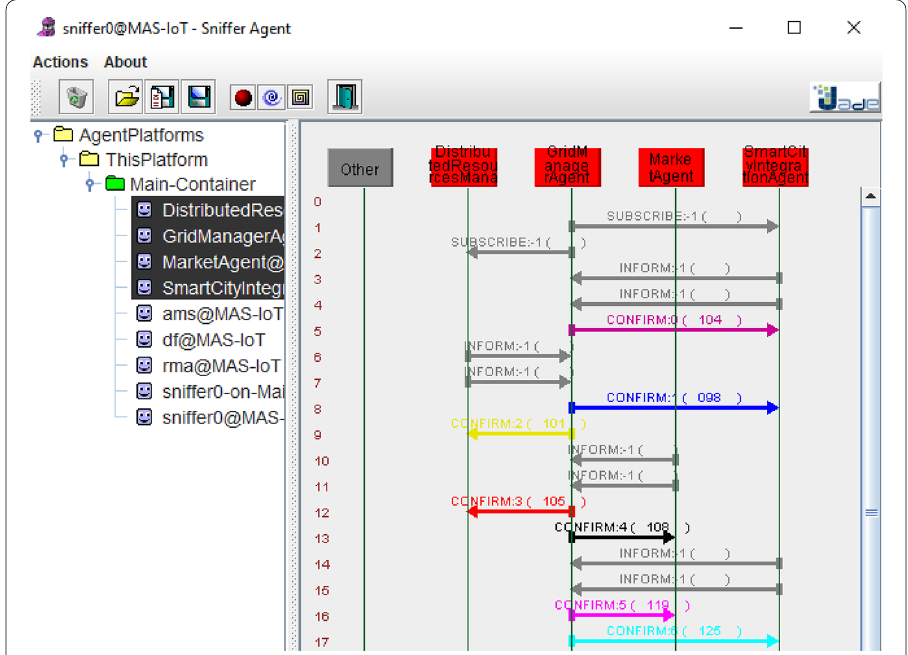
Fig. 6 Internal communication of MAS with ACL